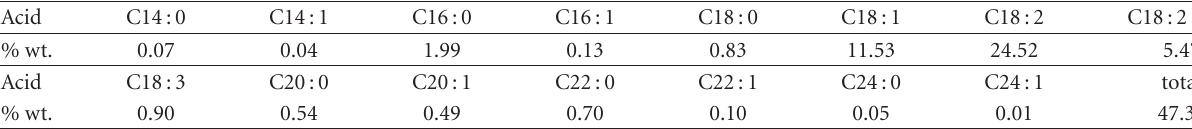
Table 2: Crude tall oil—content of free fatty acids.